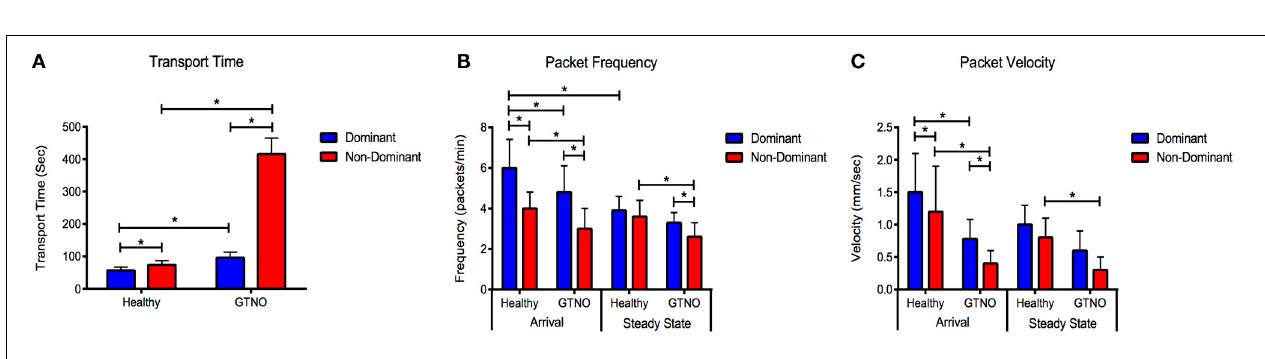
FIGURE 4 | Lymphatic function metrics in healthy and GTNO-treated cases. Compiled data for (A) transport time, (B) packet frequency, and (C) packet velocity for the dominant and